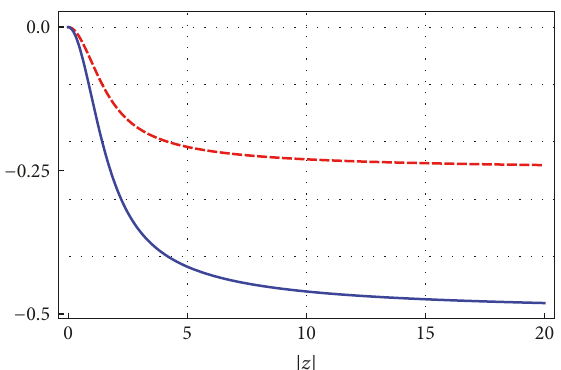
Figure 9: The blue curve represents the Mandel parameter 𝑄 of the SU (1, 1) coherent states (34) as a function of |𝑧| . This converges to −1/2 as |𝑧| → ∞ . The dashed-red curve represents the Mandel parameter for both the horizontal and vertical signals at the output ports of a beam splitter when it is injected with the state |𝑧 퐸 , 0⟩ , where |𝑧 퐸 ⟩ 푁 is the coherent state (34).